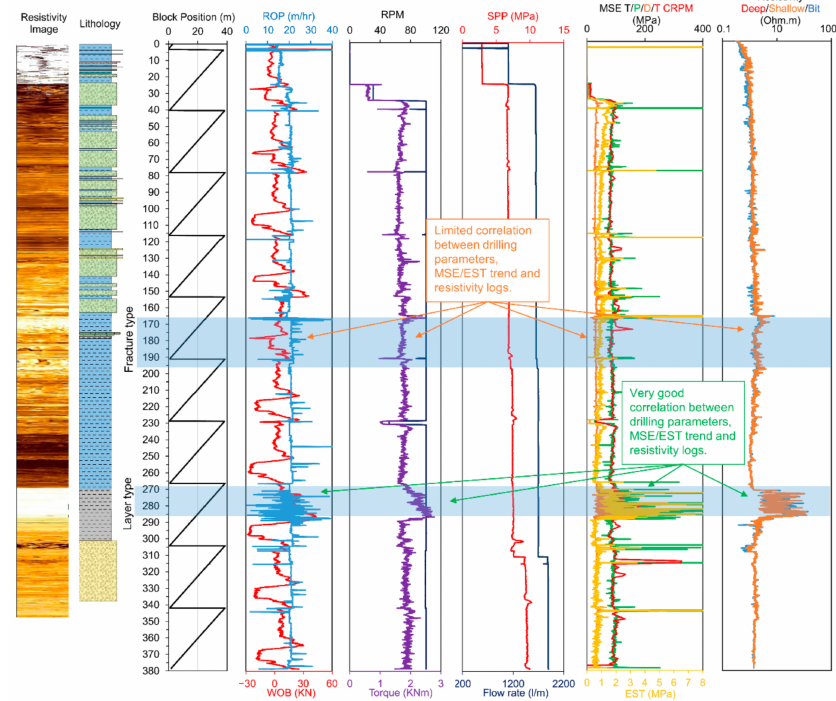
Figure 12. Depth-based drilling data series for wellbore NGHP-02-23A correlated with image log and lithology column ( left side of the plot) and resistivity data ( right side). Shaded areas present the two gas hydrate intervals detected in the wellbore by MWD/LWD logging